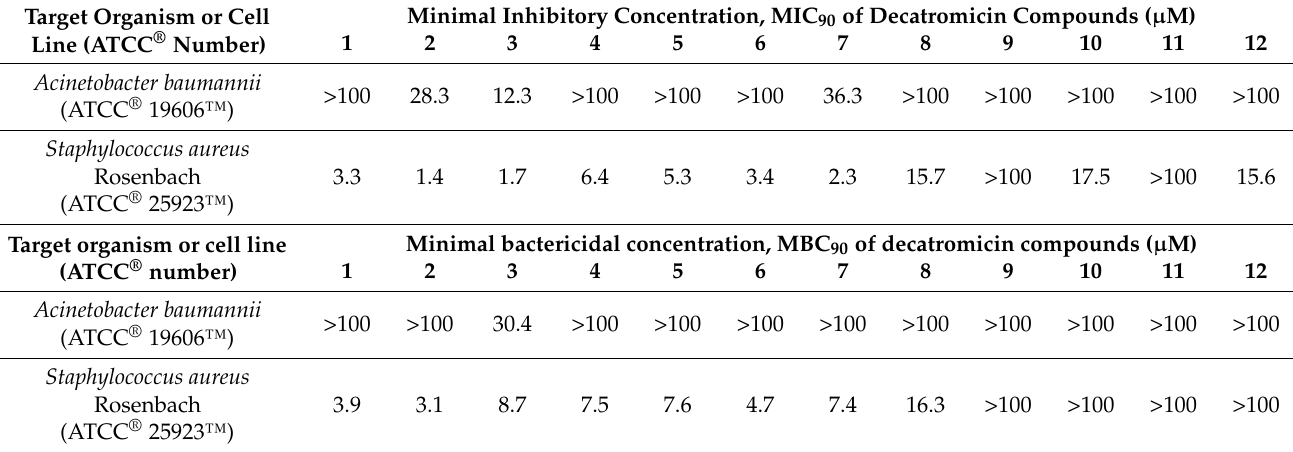
Table 3. Biological activities of compounds 1 – 12